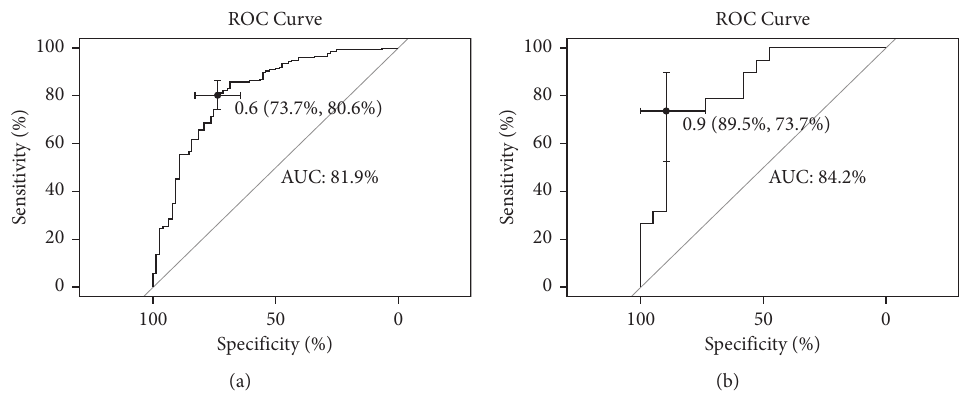
Figure 3: Received operating characteristics (ROC) curves of the nomogram for the training set (a) and the testing set (b).